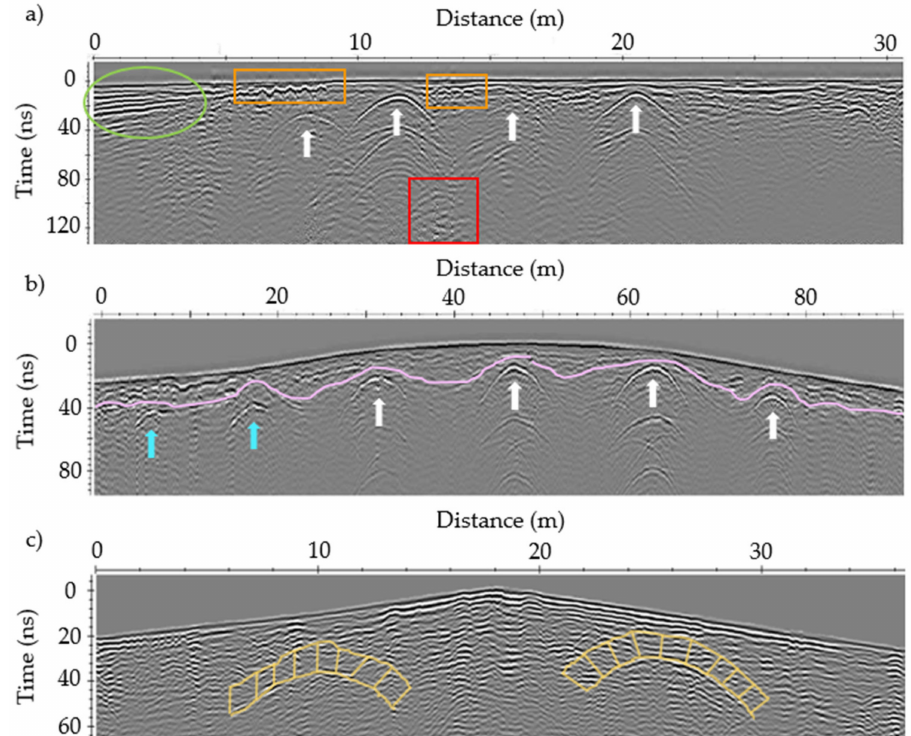
Figure 9. Examples of information obtained by GPR surveying on stone masonry arch bridges: (a) Traba bridge (Noia, Spain) showing an ancient profile (green ellipse), evidence of reinforced concrete used for restoration (orange rectangles) and presence of a void in a pier (red square); (b) Monforte bridge (Monforte de Lemos, Spain) displaying the interface between the original and the new backfill used for restoration (pink line) and the existence of two hidden arches (cyan arrows); (c) Vilanova bridge (Allariz, Spain) reproducing the voussoirs of the arch-ring (yellow